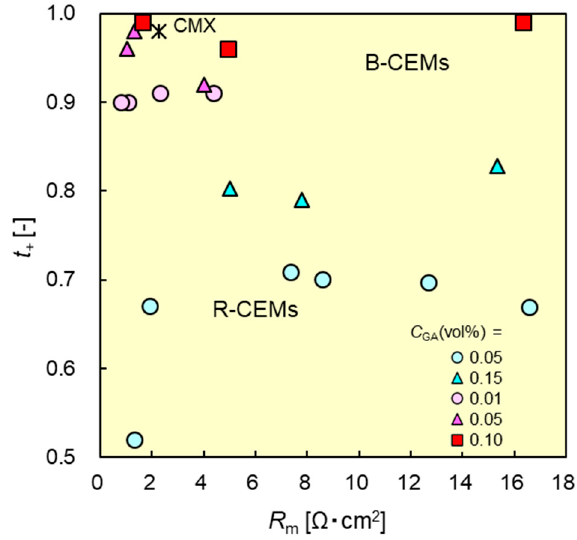
Figure 9. Relationship between dynamic state transport numbers t d+ and membrane resistance R m of B-CEMs and R-CEMs. Red and blue symbols denote the data of B-CEMs and R-CEMs, respectively. * : The data of the commercial CEM (CMX).